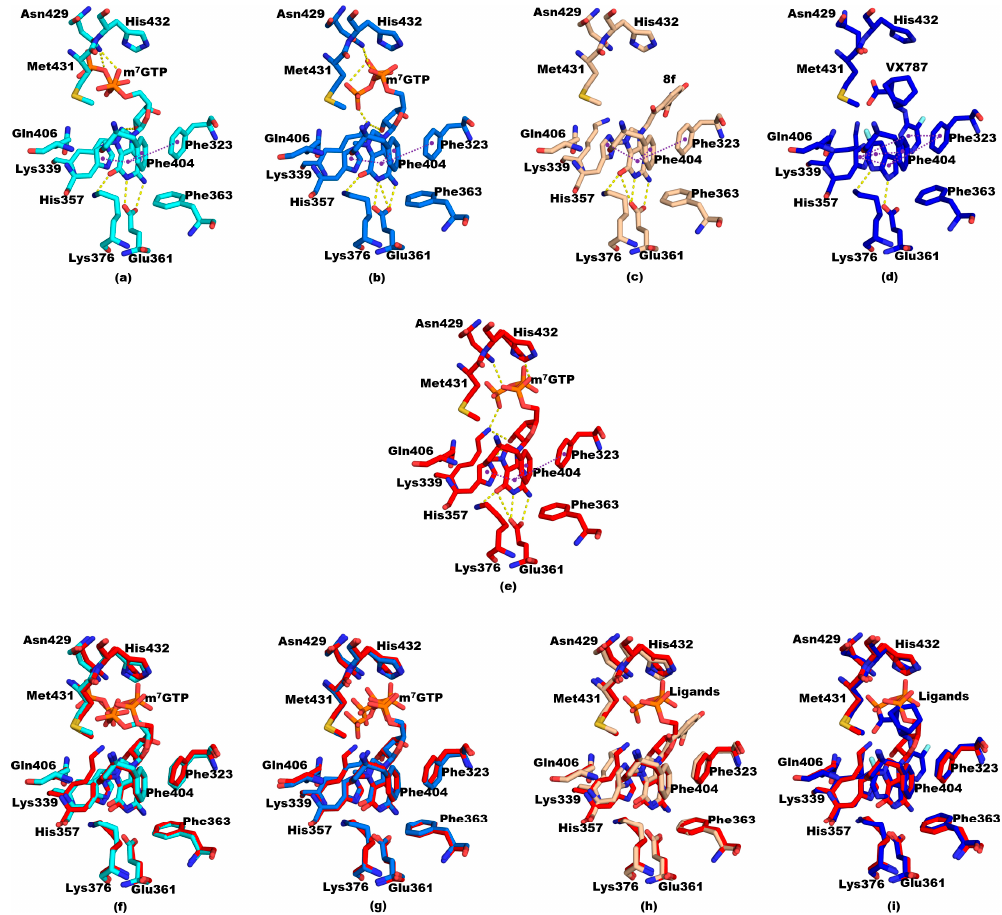
Figure 3. ( a ) m 7 GTP-bound PB2cap from A/Duck/Shantou/4610/2003 (H5N1) (PDB code: 4CB4)